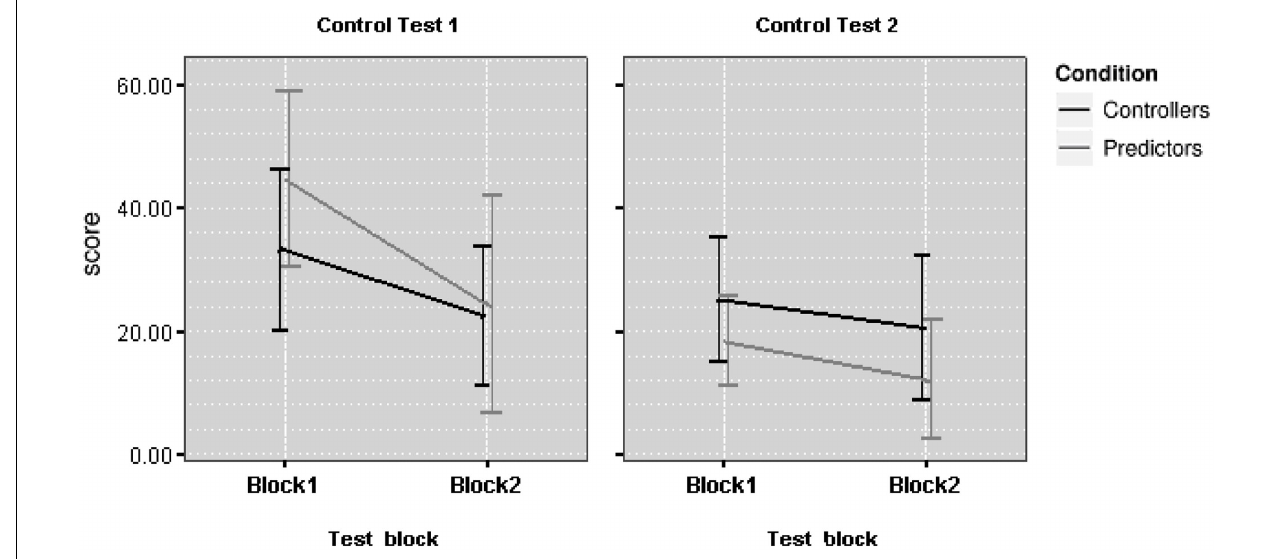
Figure 5 . A 2 × 2 × 2 ANOVA was conducted with Test and Block as within-subject factors,and Learning Mode (prediction,control) as between subject factor. As in Experiment 1, there was a main effect of Block, F (1,28) = 26.01, p < 0.001 , partial η 2 =